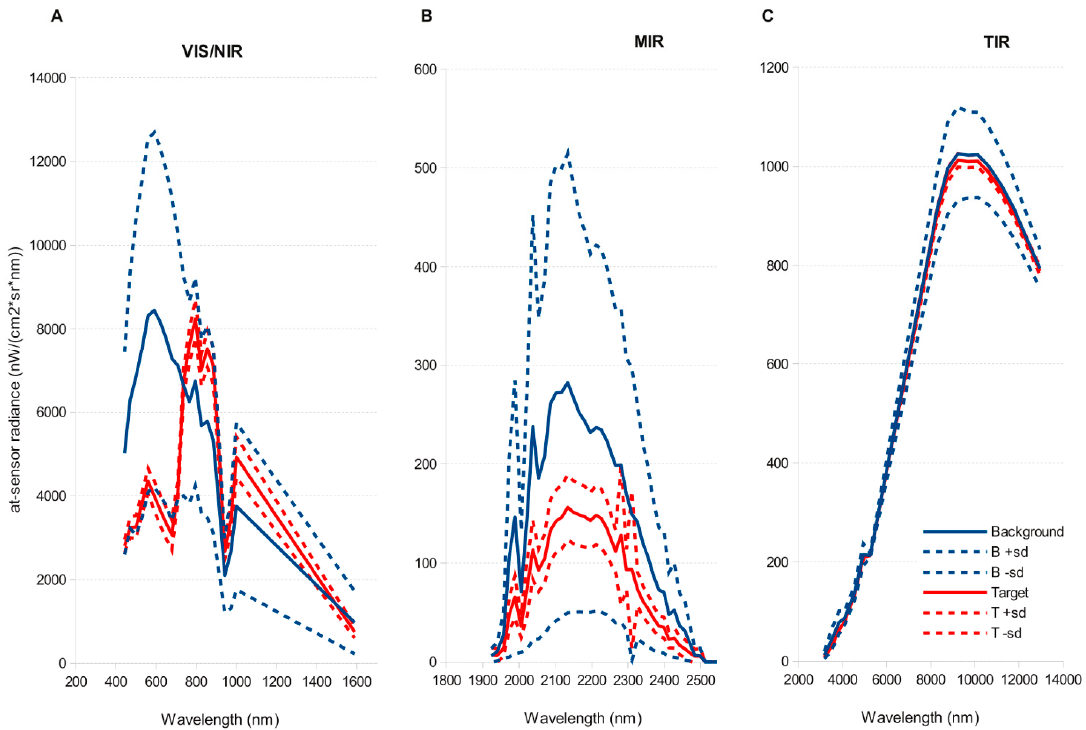
Figure 3. Mean ± s.d. of target and background radiance spectra as extracted from the AHS image. ( A ) Visible and near-infrared. ( B ) Short-wave infrared. ( C ) Thermal infrared.